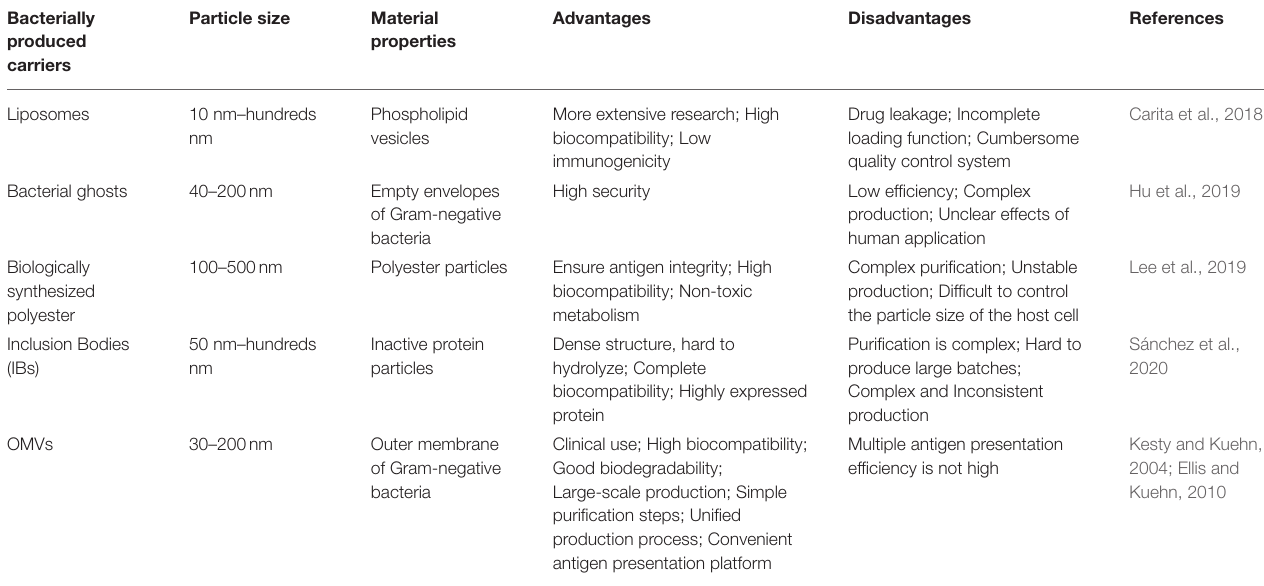
TABLE 1 | The advantages and disadvantages of OMVs and other bacterial small molecules. Bacterially